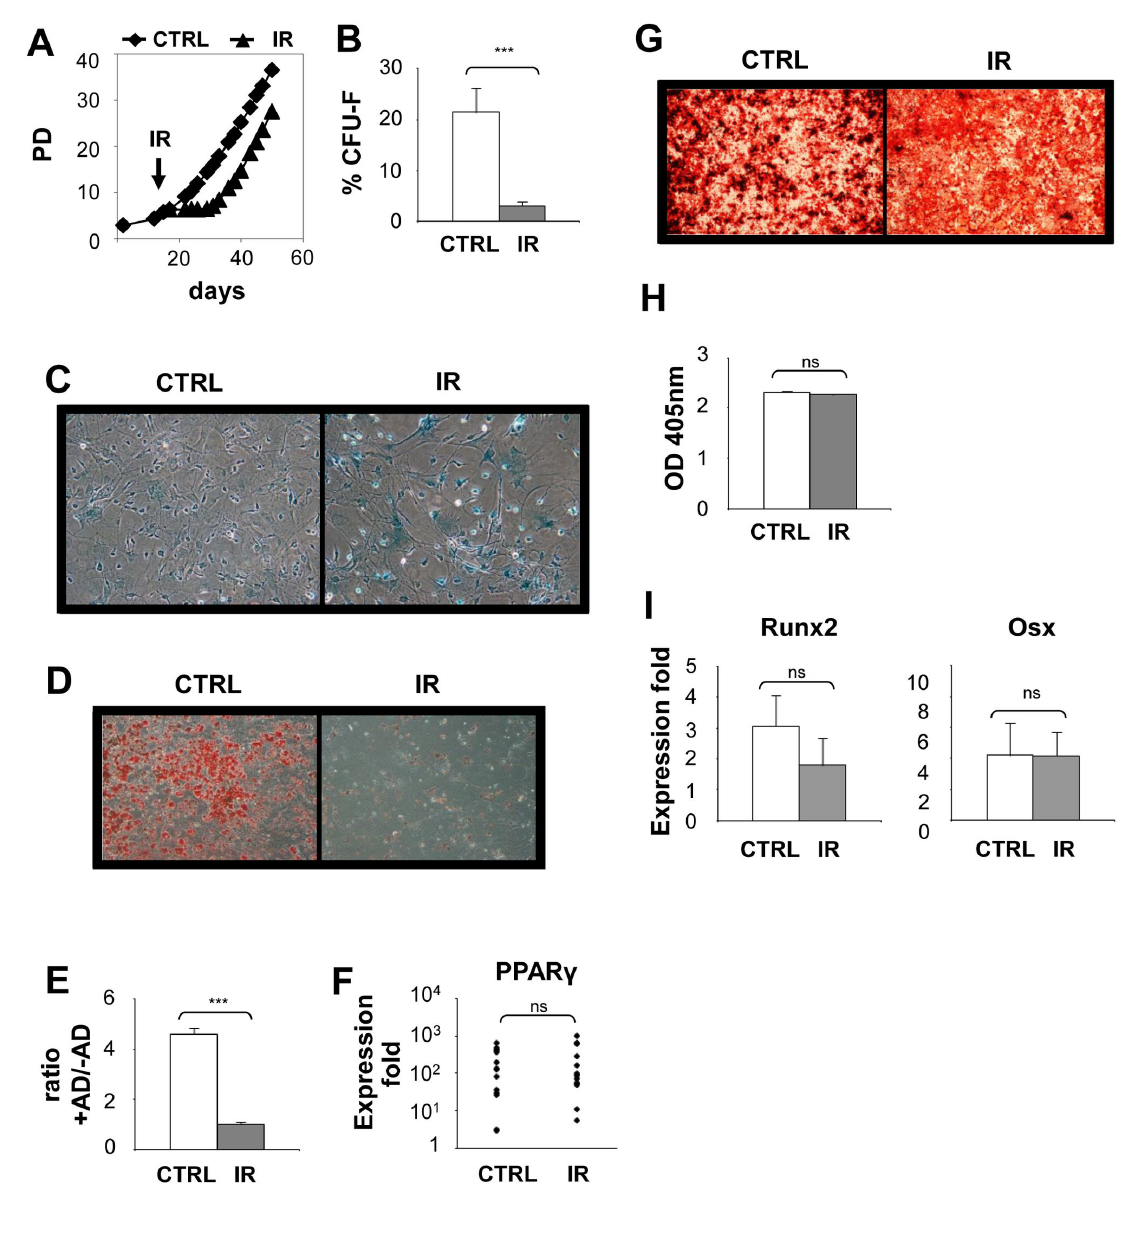
Figure 5. Loss of osteogenic but not adipogenic potential in senescent MSC is p53 dependent. ( A ) MSC derived from p53 knockout mice (MSC-p53KO) were exposed (IR) or not (CTRL) to 10 Gy IR and one week later stained for the expression of SAβ- gal activity. ( B ) The proliferation capacity of MSC-p53KO was determined using a CFU assay one week post-exposure or not to IR. ( C ) One week post exposure or not to IR, MSC-p53KO were placed in adipogenic differentiation media for 7 to 14 days. Representative photographs showing lipid accumulation stained with Oil Red O is shown. Scale bar: 200µm. ( D ) Quantification of lipid accumulation has determined by the extraction of Oil Red O staining and detection by spectrophotometry. ( E ) Expression of PPARγ was determined by quantitative real-time PCR using RNA extracted from control and IR-induced senescent MSC-p53KO cultured in adipogenic differentiation media. ( F ) One week post exposure or not to IR, MSC-p53KO were placed in osteogenic differentiation media for 14 to 21 days. Representative photographs showing mineralization nodules accumulation stained with Alizarin Red S is shown. ( G ) Quantification of mineralization was determined by the extraction of Alizarin Red S staining and detection by spectrophotometry. ( H ) Expression of Runx2 and Osx was determined by quantitative real-time PCR using RNA extracted from control and IR-induced senescent MSC-p53KO populations placed in osteogenic differentiation media. Mean ± standard error of at least 3 individual experiments is shown; *: p value < 0.05. doi: 10.1371/journal.pone.0073206.g005 PLOS ONE |